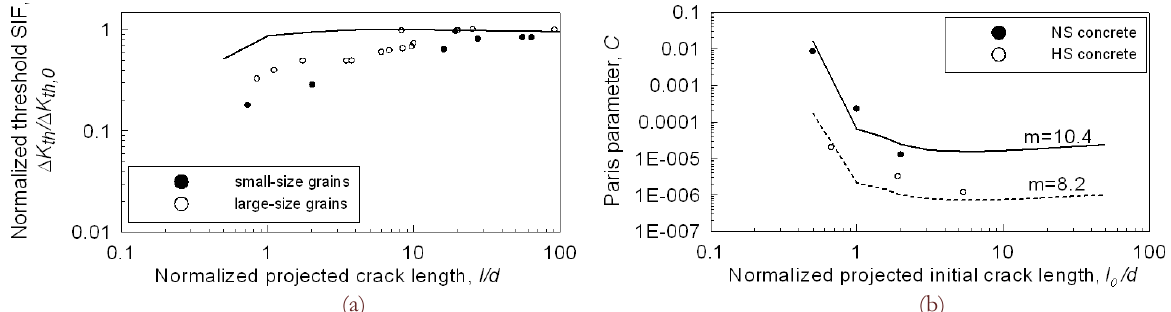
Figure 5: (a) Fatigue threshold results for mild steel [22]; (b) fatigue crack growth results in the Paris regime for concrete [23, 24]. C